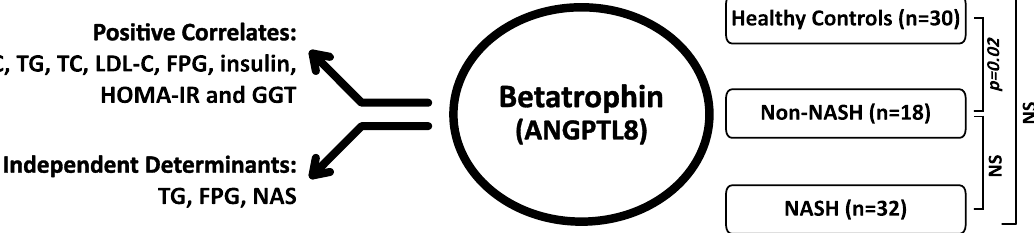
Figure 2. The main findings of the study showing the positive correlates and independent predictors of the Betatrophin levels and the differences between the study groups. Mann-Whitney U test, p < 0.05 is significant; NS: Nonsignificant; n: Number; WC: Waist circumference; TG:Triglycerides; TC: Total Cholesterol; LDL-C: Low Density Lipoprotein Cholesterol; FPG: Fasting Blood Glucose; HOMA-IR: Homaistasis model assessment of insulin resistance; GGT: Gamma glutamyl transpeptidase, NAS: NAFLD activity score.